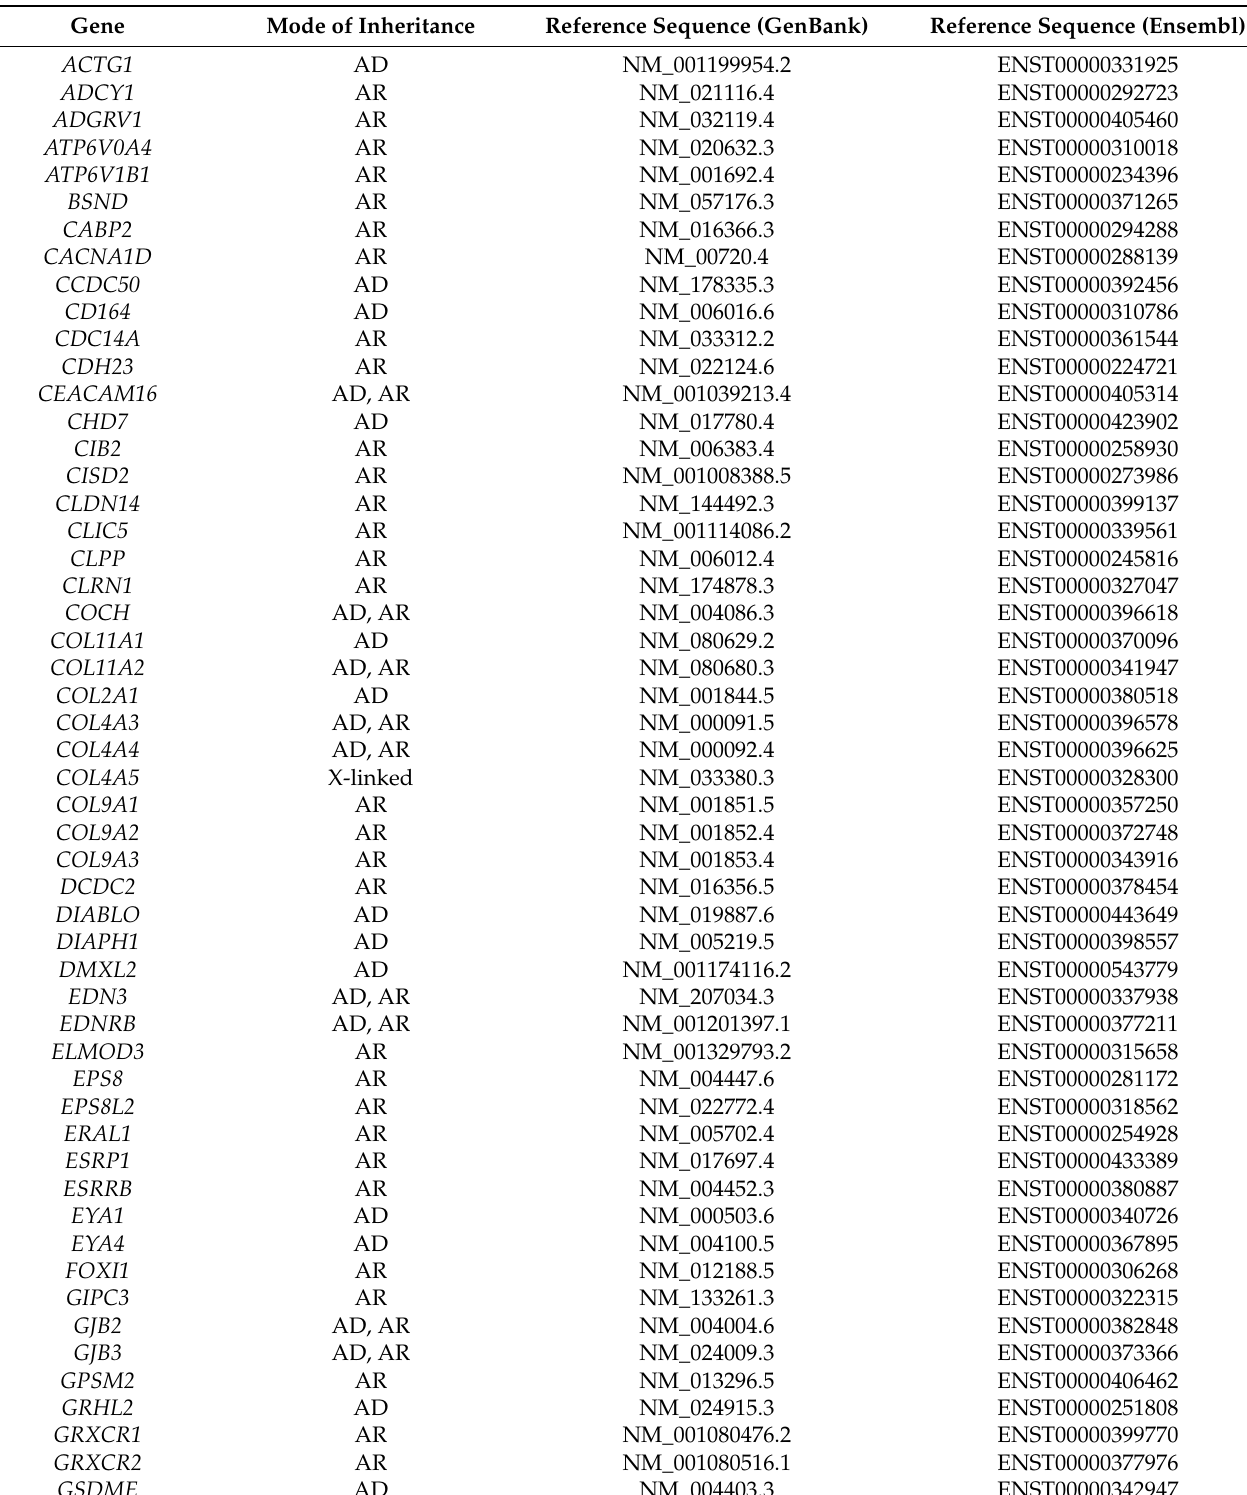
Table A1. Genes included in the exome sequencing analysis, together with their mode of inheritance and reference sequence (AD = autosomal dominant, AR = autosomal